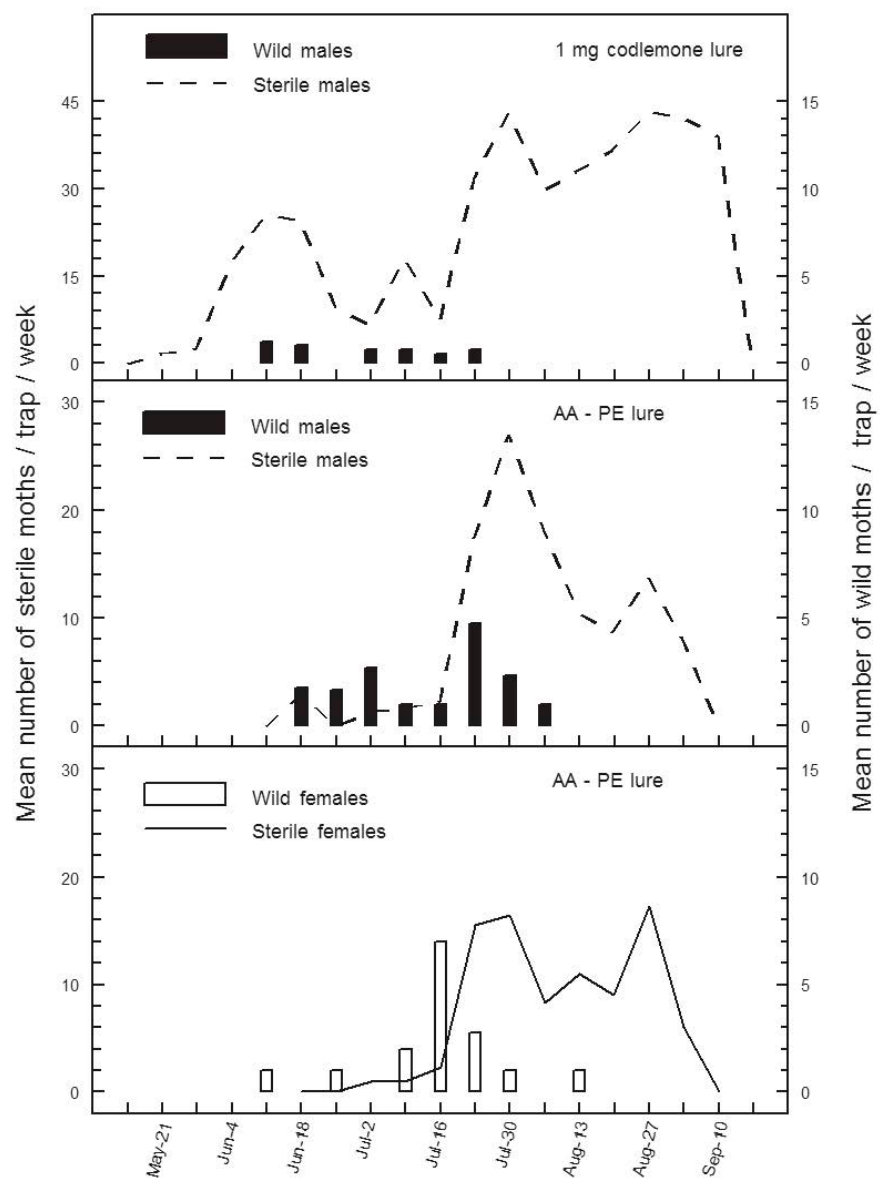
Figure 1. Mean weekly catches of sterile and wild male codling moths in wing traps baited with a 1 mg codlemone-loaded red rubber septum, and catches of male and female, sterile and wild codling moths in white delta traps baited with a propylene bottle containing 10 mL of glacial acetic acid plus a grey rubber septum loaded with 1 mg of pear ester, ethyl-( E , Z )-2,4-decadienoate (AA-PE) in 2008.